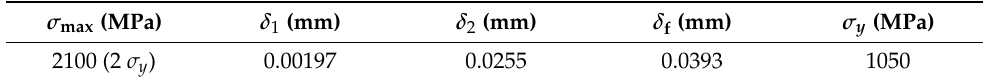
Figure 9. ( a ) The J-R curves of the uncharged specimen and ( b ) load-displacement curves of uncharged specimen corre- sponding to computational and experimental data. (Exp: experiment; Sim: simulation). Table 4. The TSL parameters for the uncharged specimen.